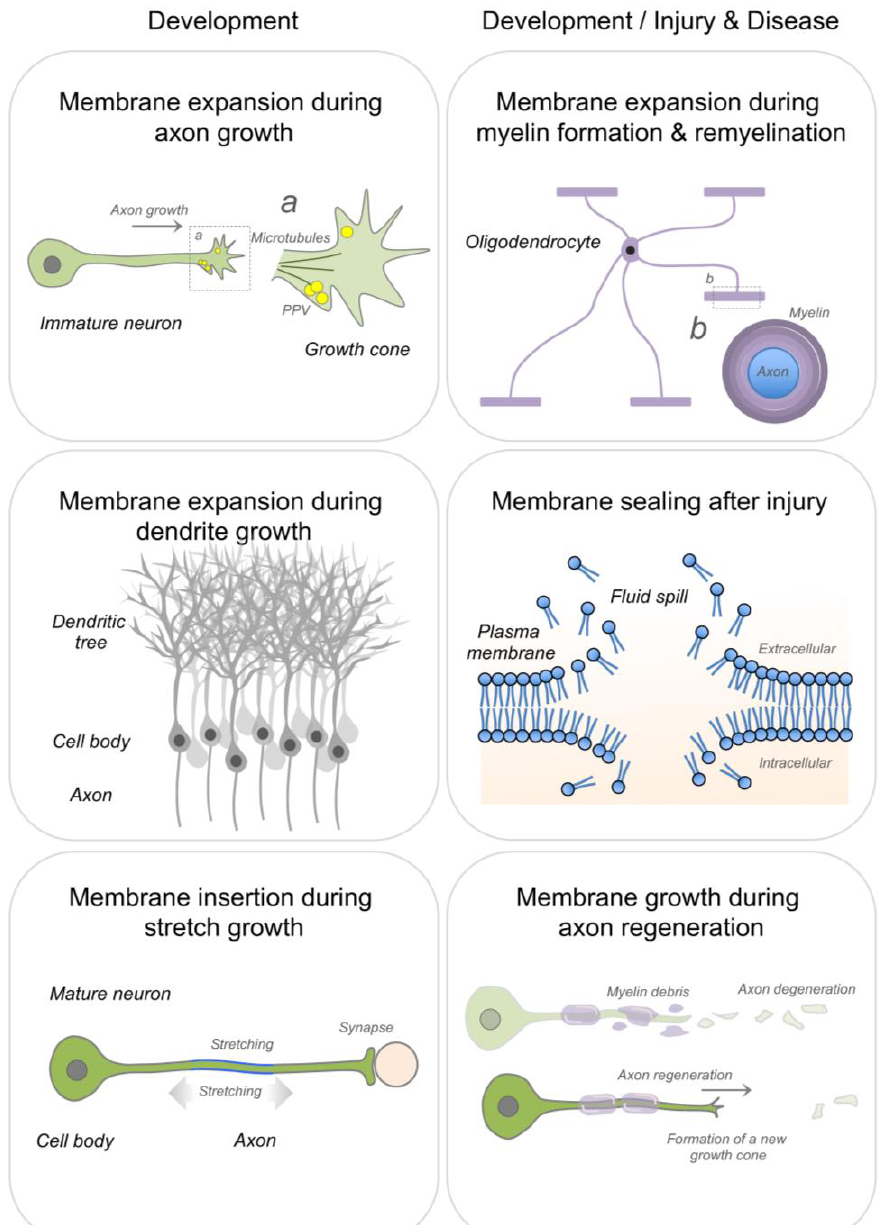
Figure 2. Membrane expansion during nervous system development and repair.